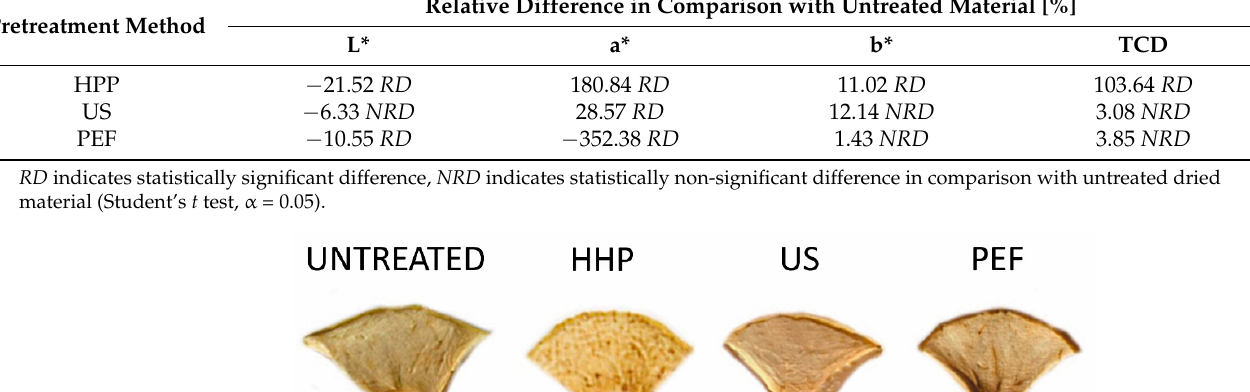
Table 3. Relative values of color parameters of dried apples pretreated with different methods calculated in reference to control (untreated) material.